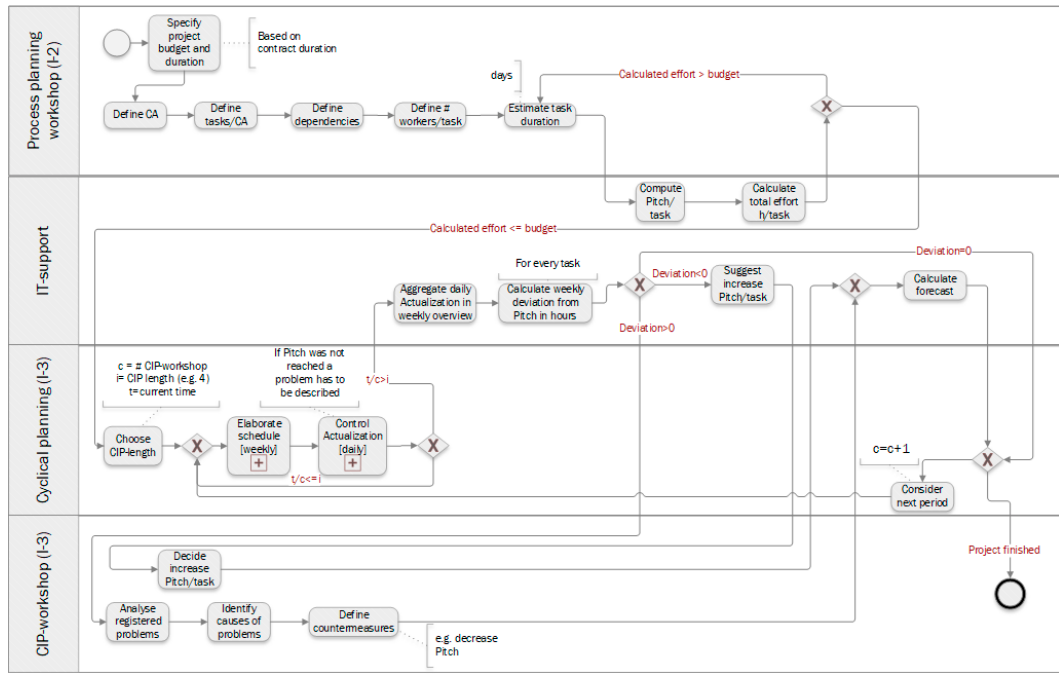
Figure 10. Process of IT support ‘Modeling-Scheduling-Actualization’ with BPMN.